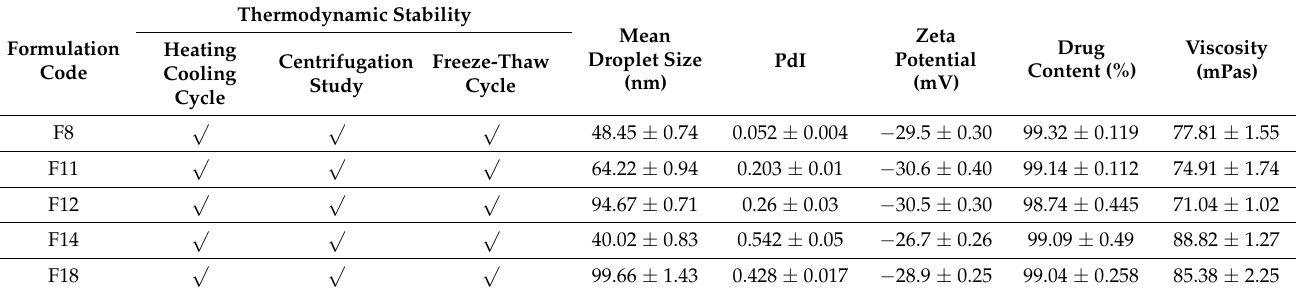
Table 1. Characterization of selected TMQ-loaded NE for thermodynamic stability, droplet size distribution, zeta potential, % drug content, and viscosity.